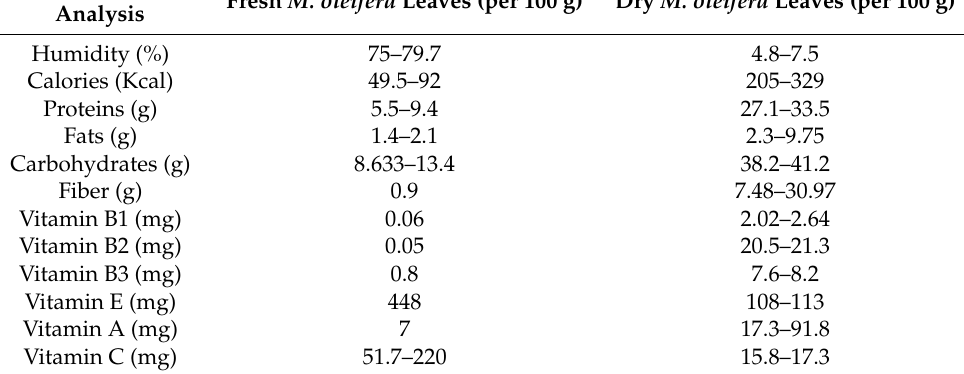
Table 5. Composition of macronutrients and vitamins of group B, A, C, and E in dried and fresh leaves of M. oleifera (Sources: